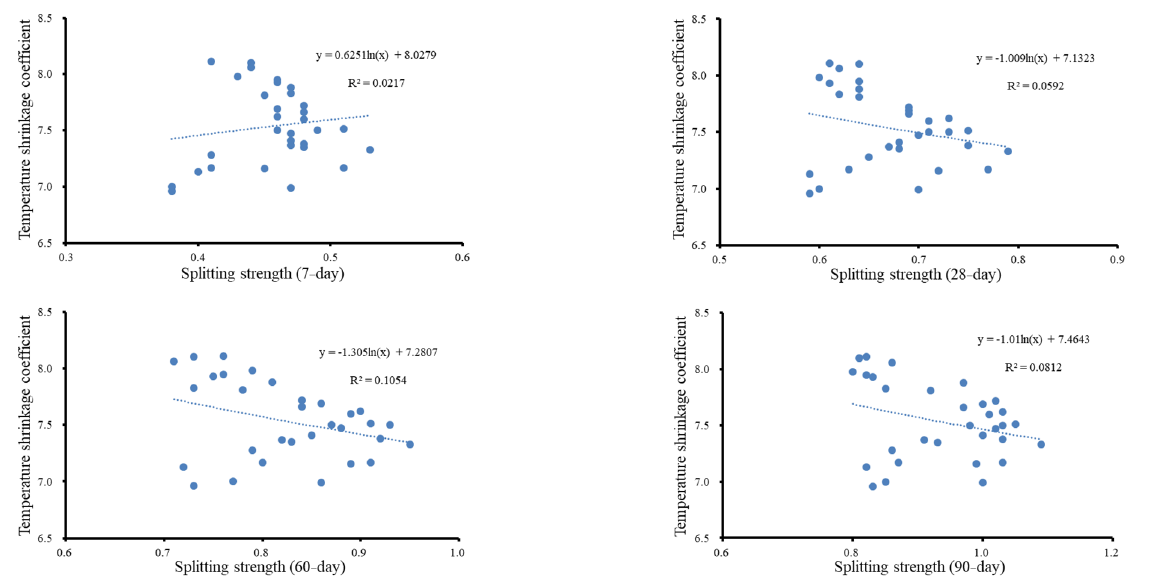
Figure 11. Relationships between spliing strengths and temperature shrinkage coefficients.